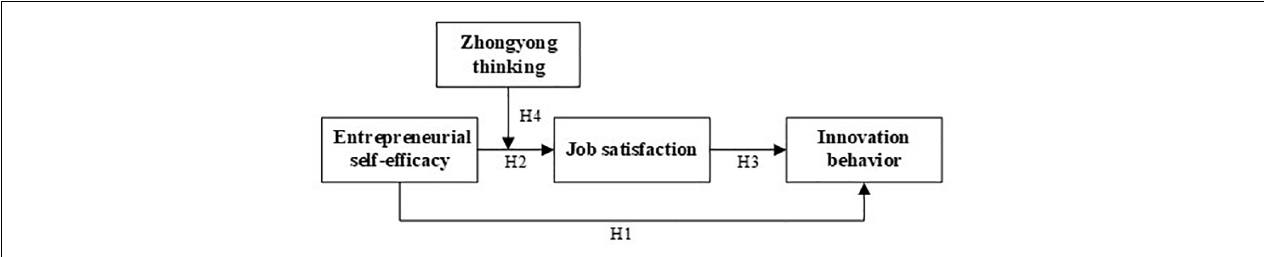
FIGURE 1 | Conceptual model of entrepreneurial self-efficacy influencing innovation